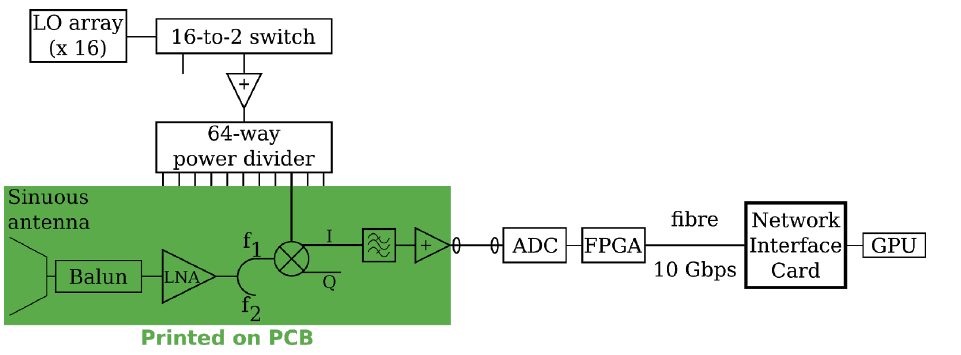
Figure 1. A block circuit diagram of the circuitry for one of two antenna polarisations in the SAMI-U array. Repeating sections have been omitted. The components in the green section will be printed or surface mounted on PCB which will feed the IF into the digitisation system.